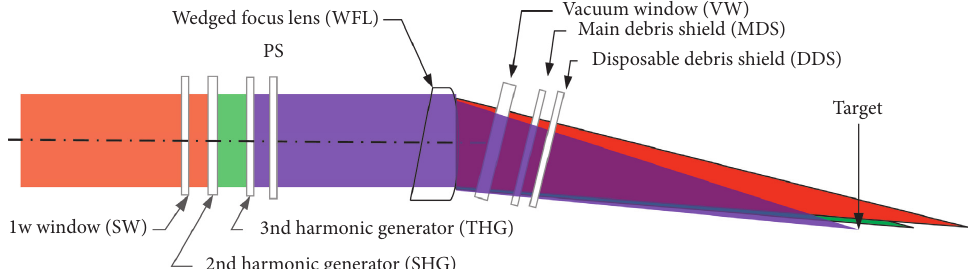
Figure 1: Schematic of the optical configuration of compact FOA. Separated FOA pulls large spacing from crystal to WFL to reduce the crosstalk of stray light and concentrate stray light. Moreover, it puts the crystal and WFL in atmosphere to delay the chemical film degradation and minimize out-gassing of organics. However, the risk of damage and crack of vacuum window increases sharply in separated FOA. The compact FOA avoids the risk of vacuum window cracking, but the small distance from the crystal to the focusing lens makes it more difficult to optimize the design and management of stray